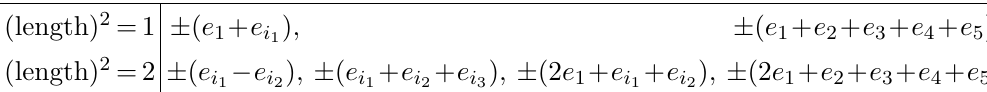
Table 4 . Elements of square-length 1 and 2 in the lattice (cid:3) A for A = f 2 ; 1 f (cid:0) 1 g . The e i ’s are the elements of the canonical basis of Z f . The indices i k = 2 ; : : : ; f are all distinct. The last column is present only for the Argyres-Wittig model with (cid:1) = 6. The (cid:12)rst row yields also the list of integral solutions to eq.